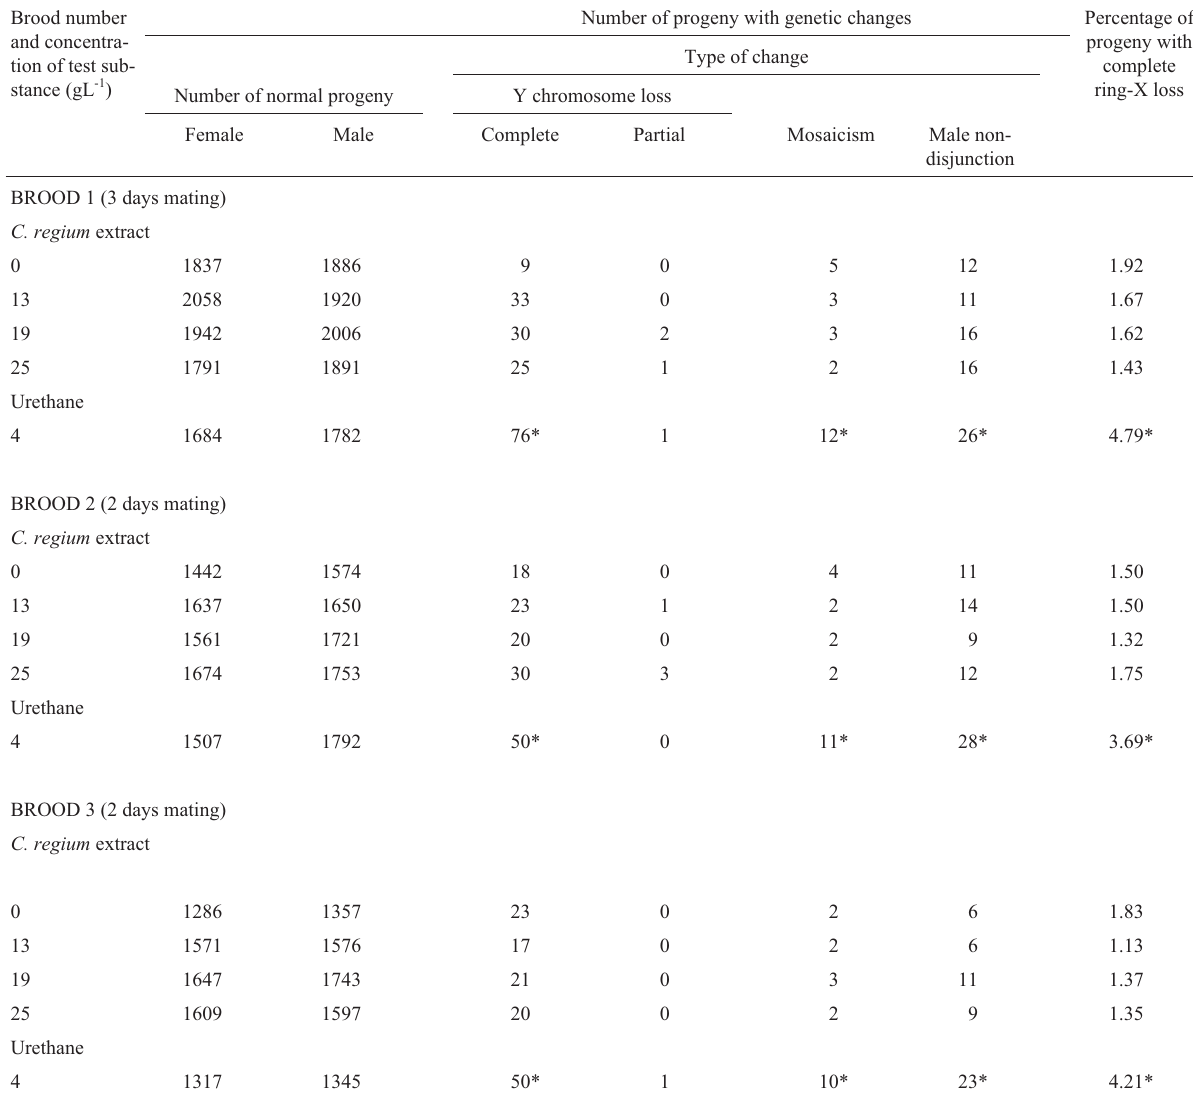
progeny with complete ring-X